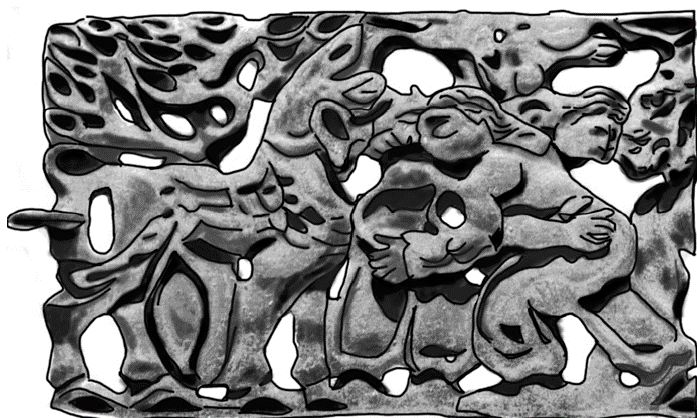
Figure 24. A bronze plate carved with the depiction of wrestling in Xiongnu style. The late period of the Warrior States. Sketched by author. Picture source: Cui (2003), p. 118.